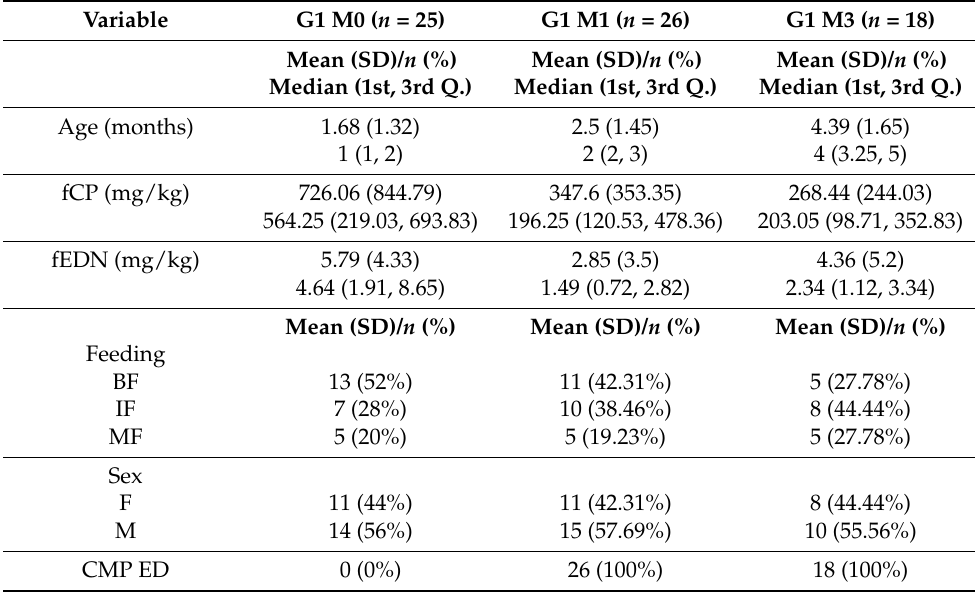
Table 1. Summary of fCP and fEDN in non-IgE-mediated CMPA children (G1) before (M0) and after one (M1) and 3 months (M3) of the CMP elimination diet.